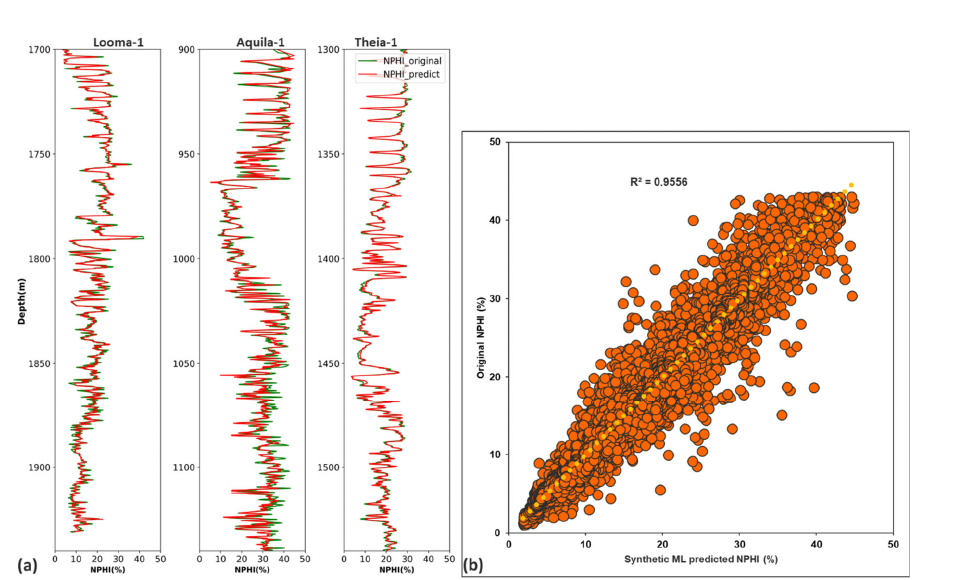
Figure 7. ( a ) Comparison of the original NPHI (green) and random forest predicted NPHI log (red) for three wells in the Goldwyer formation. Test well Looma ‐ 1 achieved a prediction accuracy with R 2 value of 0.93. ( b ) Cross ‐ plot of the original NPHI and estimated NPHI log using random forest predictor of the full data set. Linear regression trend line (yellow dotted line) shows R 2 value of 0.96.